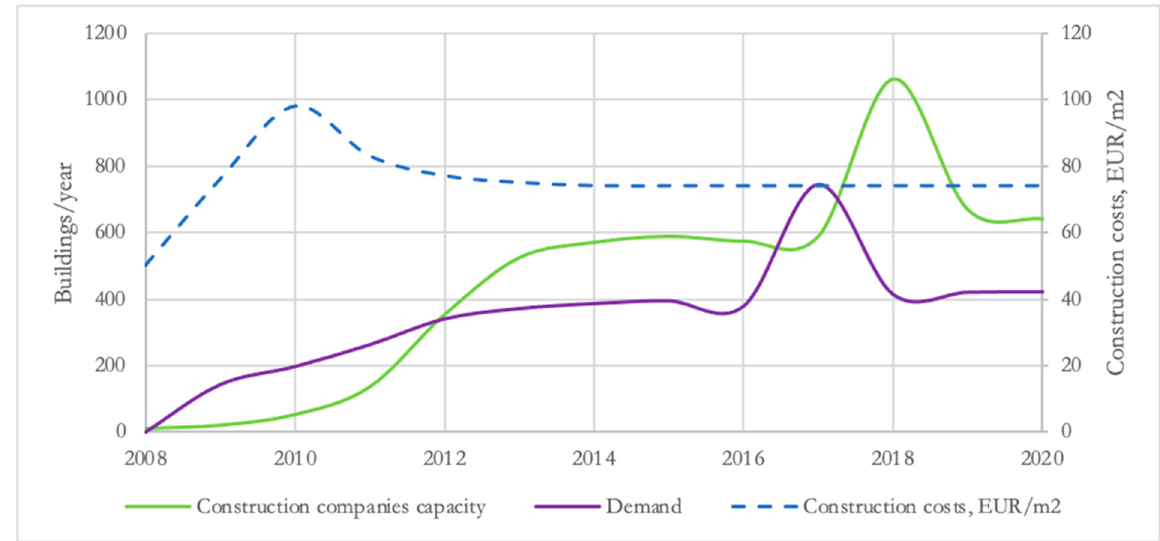
Figure 15. Simulated supply, demand, and construction costs of multi-family buildings and public sectors with combined penalty–reward scheme and EU funding.